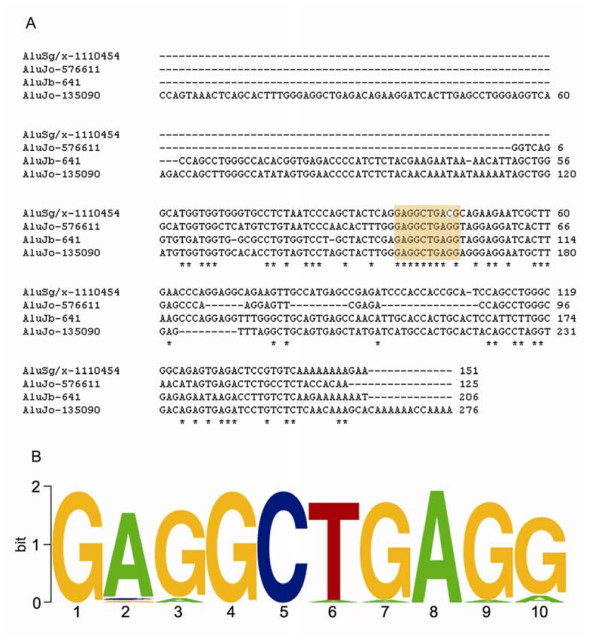
Conserved motif among different Alu sequences. A. The multiple comparison of four Alu sequences used for this experiment. B. The ATCG content map illustrates a highly conserved motif, GAGGCTGAGG, shown in the highlight box of A.